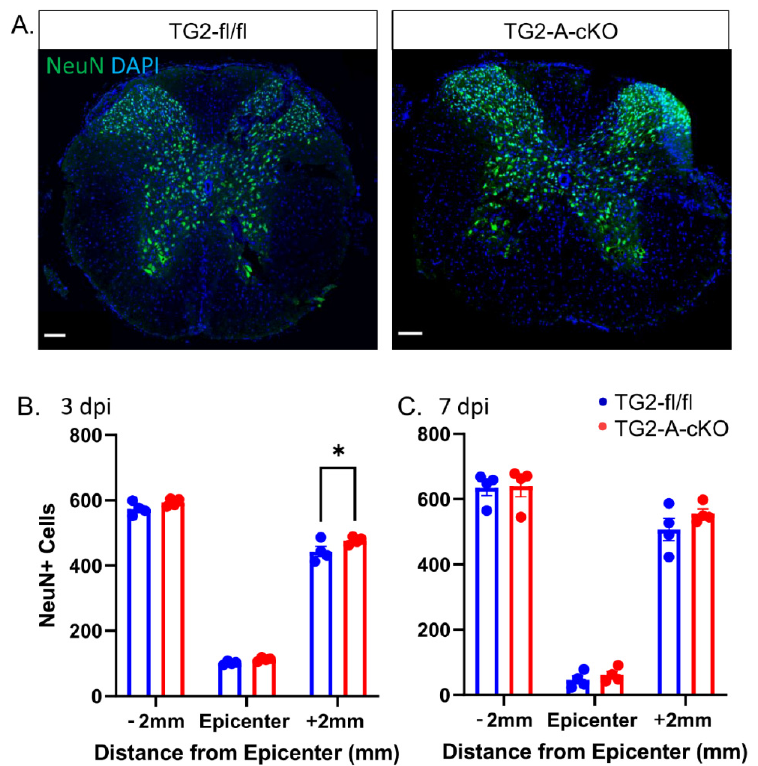
Figure 5. Deletion of TG2 from astrocytes did not result in a significant increase in neuron survival after spinal cord contusion injury. Spinal cord sections were immunostained for NeuN, a neuronal nuclear marker and the number of NeuN positive cells was determined +/ − 2 mm from the site of injury as well as the epicenter. ( A ) Representative images at 3 dpi at 2 mm caudal to the epicenter of the injury. Scale bars = 100 µm. ( B , C ) The number of NeuN positive cells was determined +/ − 2 mm from the site of injury as well as the epicenter. At 3 dpi, the number of NeuN positive cells in TG2-A-cKO was significantly increased at +2 mm (* p < 0.05); however, by 7 dpi, there was no significant difference between the TG2-A-cKO and TG2fl/fl groups. N = 4 animals per group.